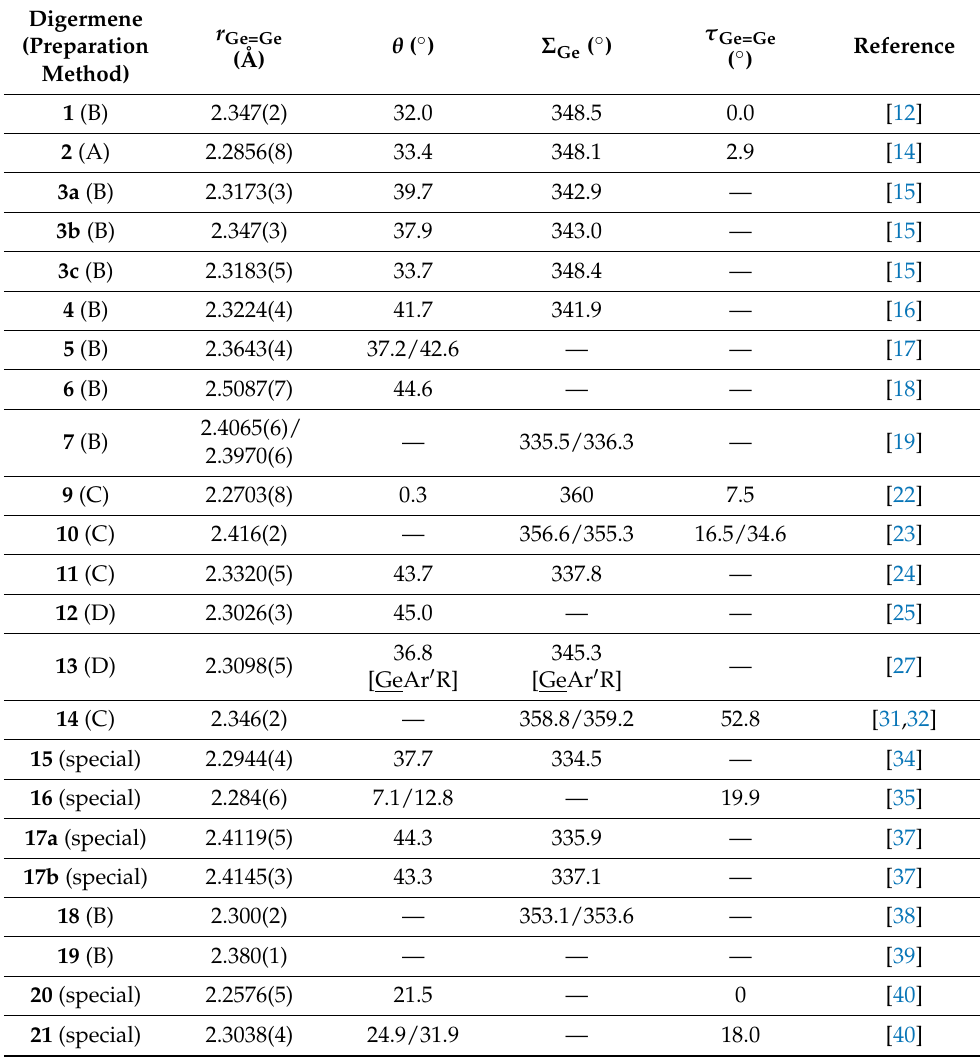
Table 1. X-ray crystallographic parameters of the stable acyclic digermenes (reported after 2000). The“ — ” implies the lack of the relevant structural